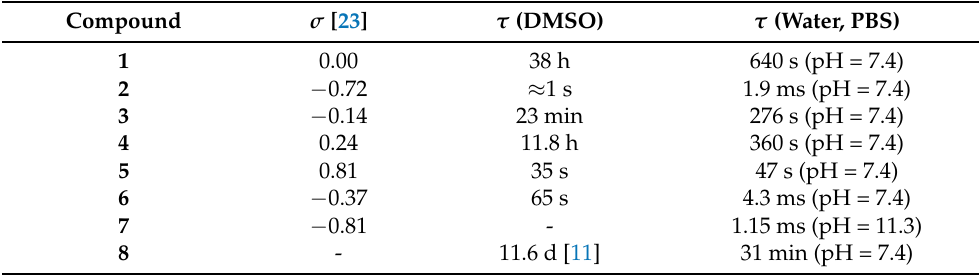
Figure 10. The dependence of the logarithm of thermal isomerization kinetic constants of Z ATPLs (ln(k)) on the length of the double bond (in Å) of the azobenzene moiety in E ATPLs. Table 2. The lifetime of Z isomers ( τ ) of ATPLs considered in the current study in DMSO and water. σ is the Hammett constant of